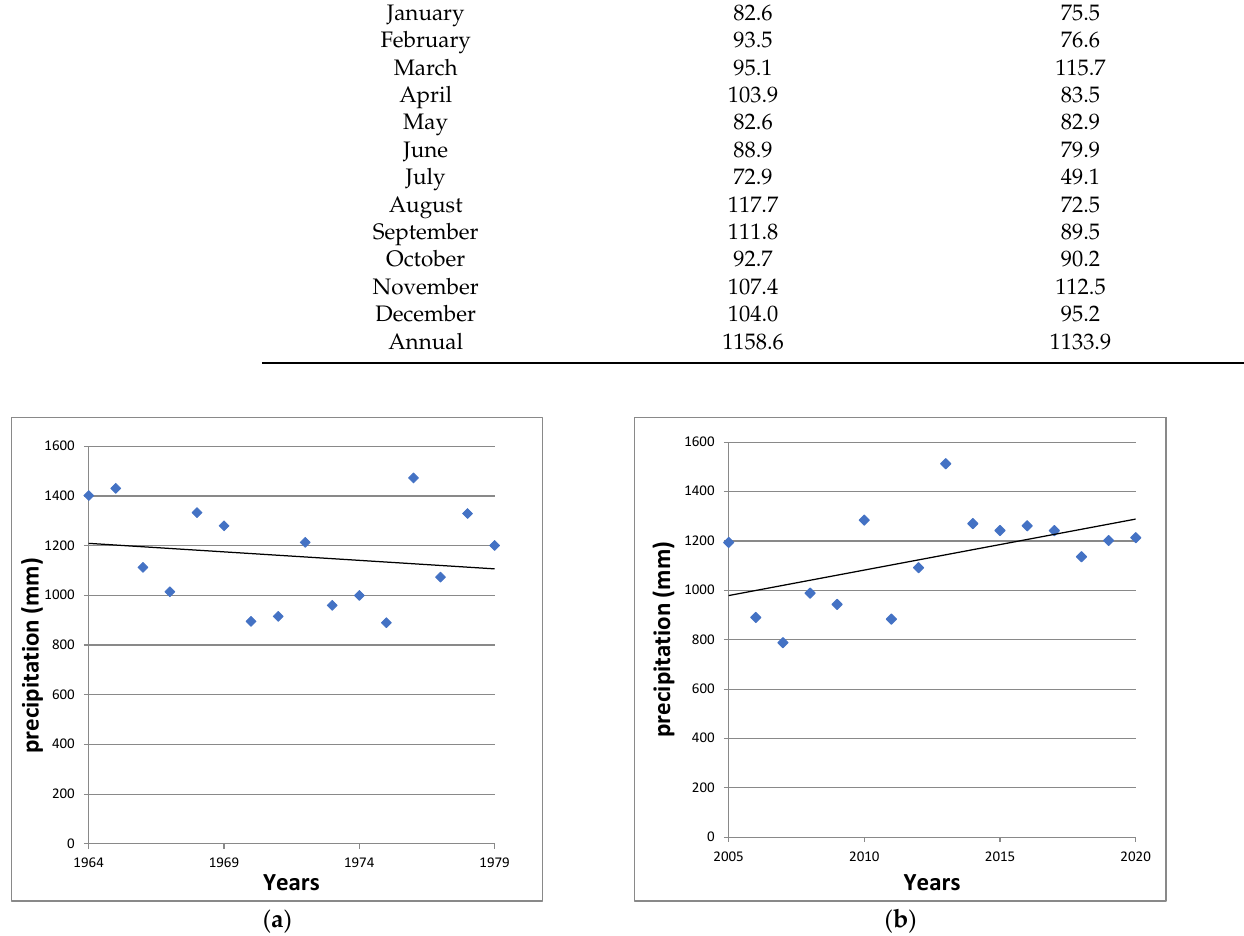
Figure 4. Annual average precipitation, in black the trend line: ( a ) 1964–1979; ( b ) 2005–2020.